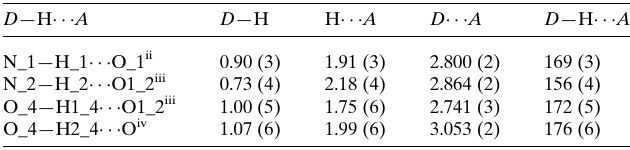
Table 3 Hydrogen-bond geometry (A˚ , (cid:5) ) for II .